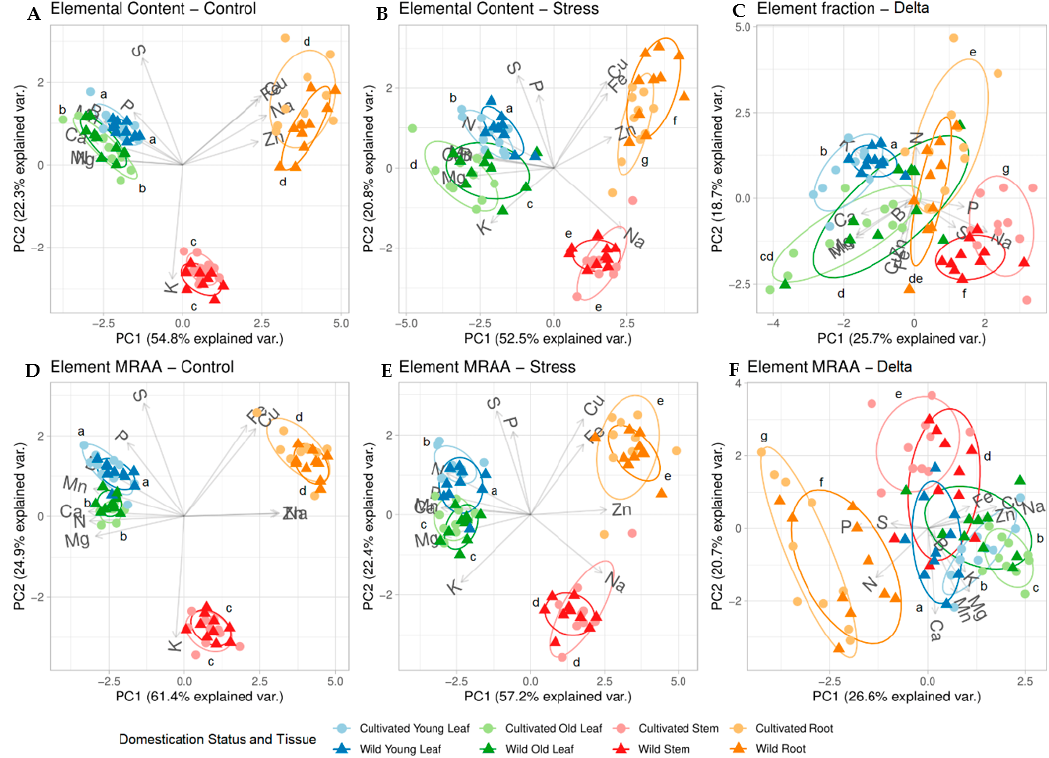
Figure 2. Principal component analyses (PCA) of elemental concentration ( A – C ) and the mass relative allocated amount (MRAA) of elements ( D – F ) in the four tissue types (young leaf, old leaf, stem, and root) for wild and cultivated H. annuus . Panels represent control treatment ( A , D ), stress treatment ( B , E ), and Delta, the di ff erence between treatments ( C , F ). Di ff erent lower-case letters denote significant Hottelings-T2 test for di ff erences ( p < 0.05) among the eight tissue type and domestication status groups.